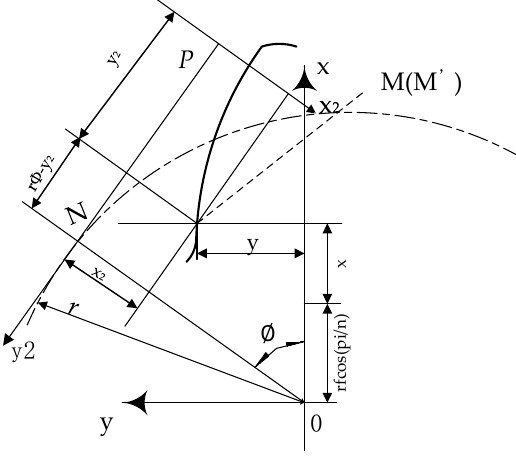
Figure 1. Schematic diagram of a gear tooth.